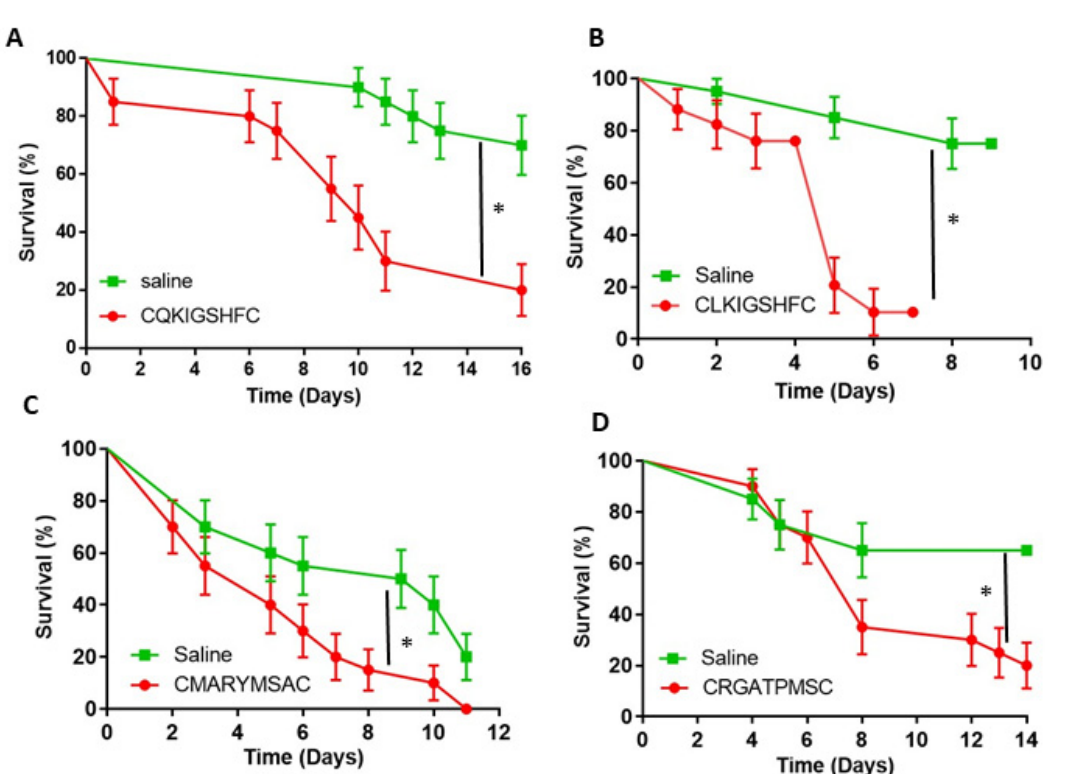
Figure 2. The survival of fire ant workers after injection of synthetic peptides. Saline was injected as a control. An asterisk (*) indicates significant differences by Logrank test ( A ) CQKIGSHFC ( p = 0.0001), ( B ) CLKIGSHFC ( p = 0.0001); ( C ) CMARYMSAC ( p = 0.0066); ( D ) CRGATPMSC ( p = 0.0180). Survival curves were compared using a standard Log-rank test survival analysis. Each replicate was composed of twenty ants, each treatment/control was replicated three times (mean ± 3 s.d).